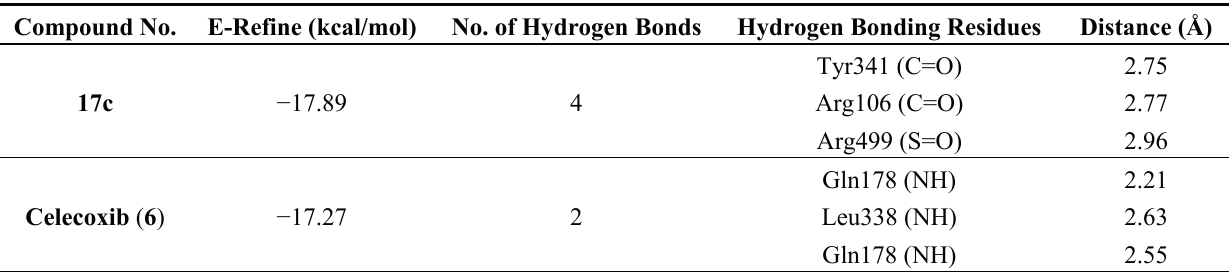
Table 4. Molecular modelling data for compound 17c and celecoxib ( 6 ) during docking in the COX-2 (PDB: ID3LN1) active